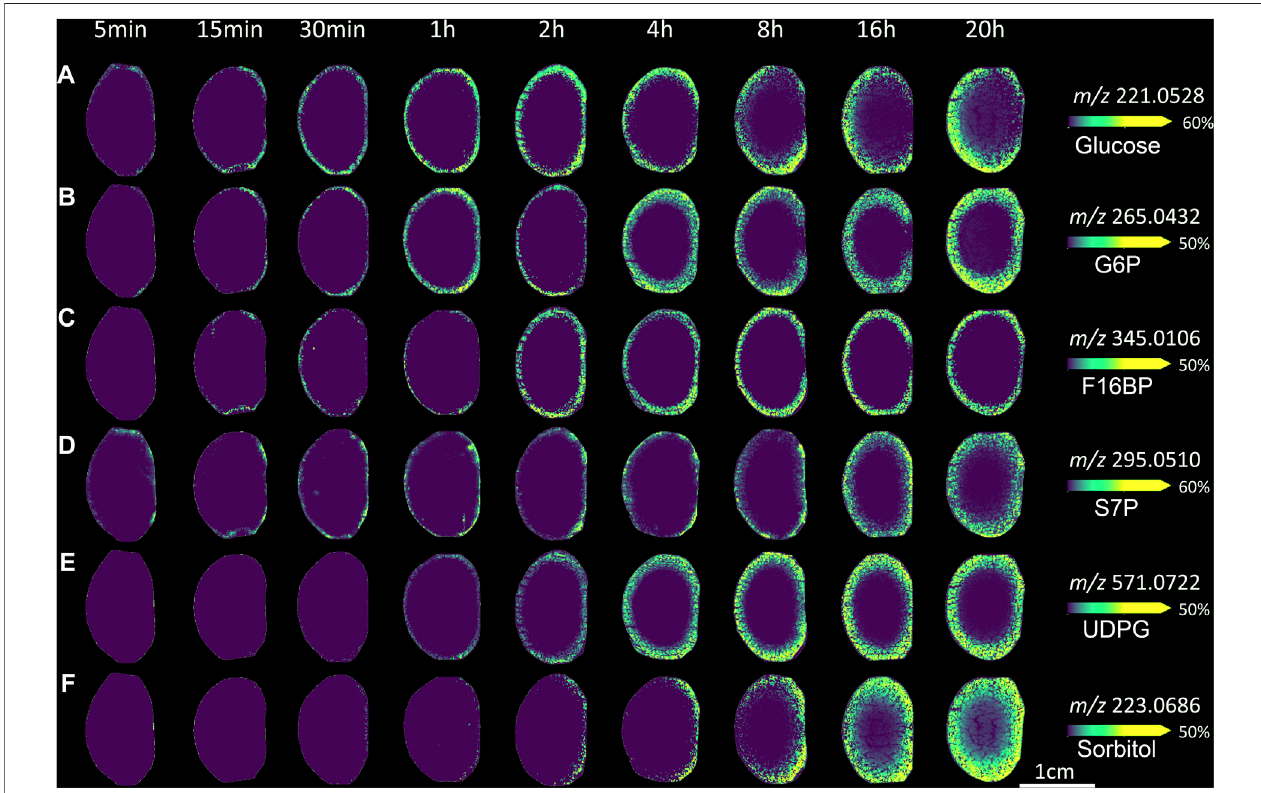
FIGURE6| Visualisinglensglucosemetabolismandtransportin exvivo bovinelens.MALDIimagesfromaxialsectionstakenfrombovinelensesorganculturedfor varying times in AAH containing 5 mM SIL glucose. Lenses orientated with anterior surface to the right. (A) m/z 221.0528 assigned to SIL glucose. (B) m/z 265.0432 assigned SIL to glucose-6-phosphate, as a marker of glycolysis. (C) m/z 345.0106 assigned to SIL fructose-1,6-bisphosphate, as a marker of glycolysis. (D) m/z 295.0510 assigned to SIL sedoheptulose-7-phosphate, as a marker of the pentose phosphate pathway. (E) m/z 571.0722 assigned to SIL UDP-glucose, as a precursor of glycogen synthesis (F) m/z 223.0686 assigned to SIL sorbitol, as a marker of the polyol pathway. G6P = glucose-6-phosphate, F16BP = fructose-1,6- bisphosphate, S7P = sedoheptulose-7-phosphate, UDPG =